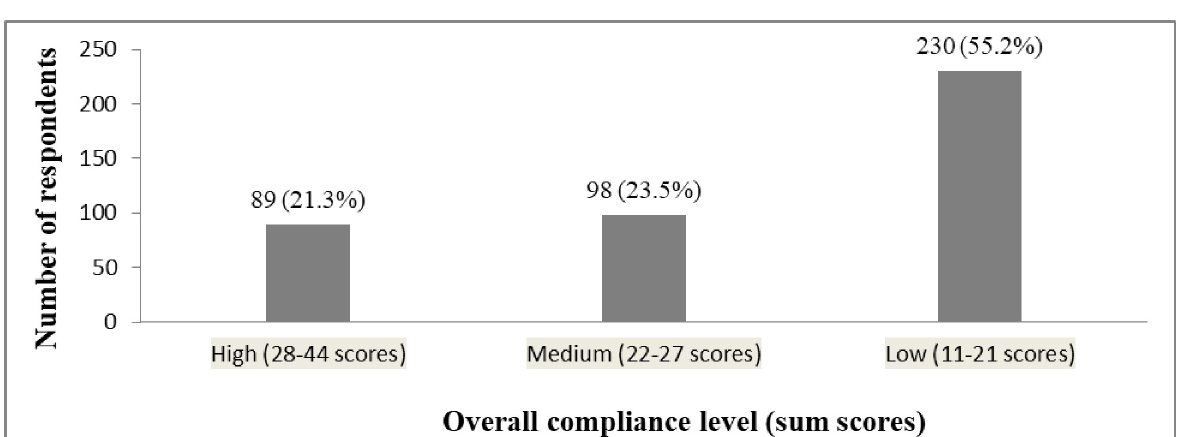
Fig 2. The participants’ overall compliance level with COVID-19 preventive